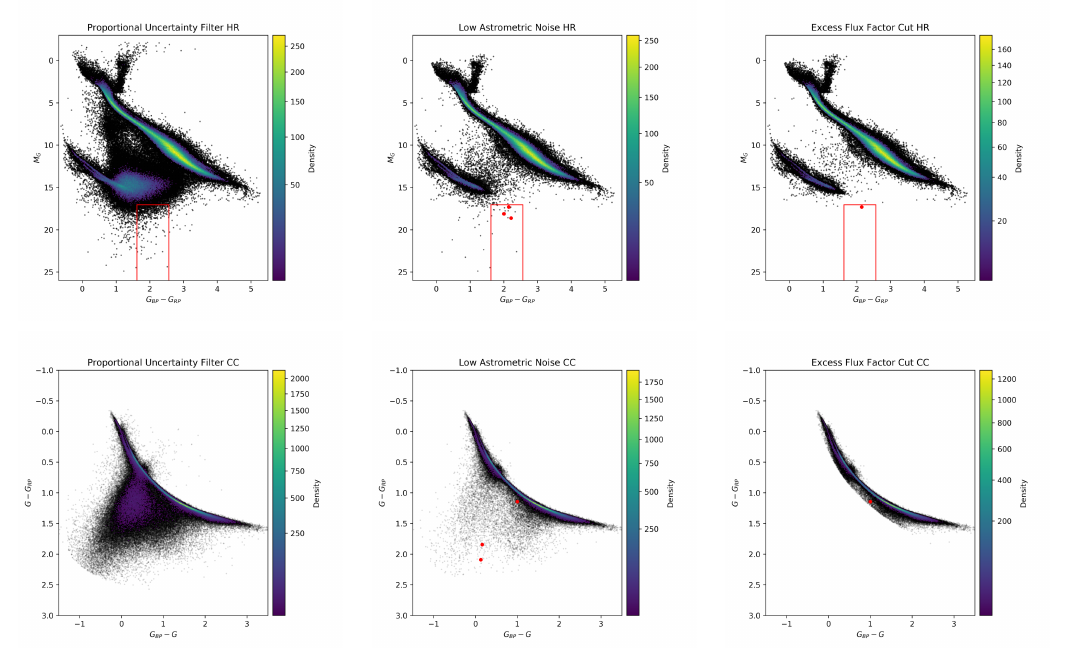
Figure 2. These figures are the HR (top) and CC (bottom) diagrams for the GAIA data sets with finer filter settings. On the left are sources selected with parallax and flux error filters; on the middle are those selected by an additional astrometric noise cut; and on the right are those that survive an additional excess flux cut. The predicted mirror star region is overlaid on top of HR